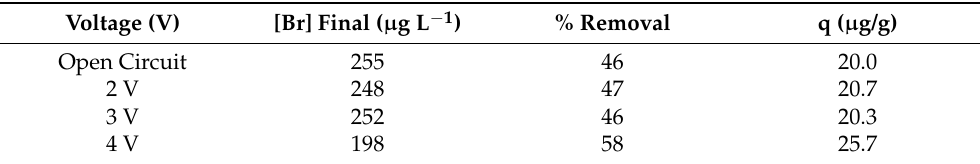
Table 4. Total bromine concentration at the end of the experiment, % removal and amount adsorbed at equilibrium on activated carbon in different electroadsorption